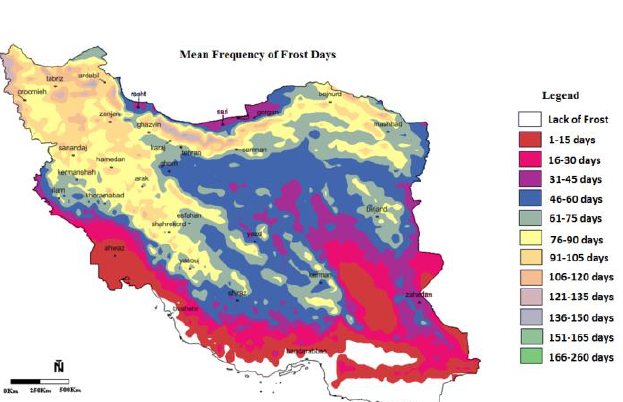
Figure 8. Map of mean Julian day of the last frost in Iran